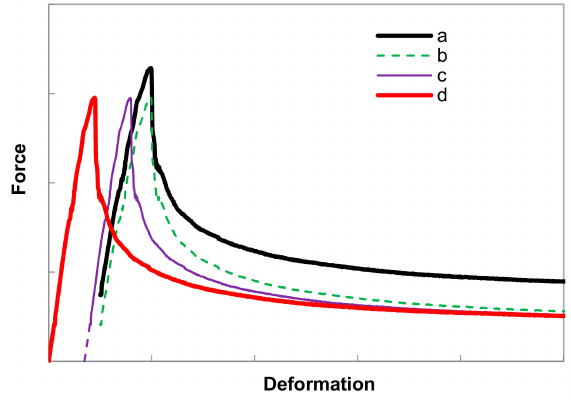
Figure 9. Schematic view of corrections made on the experimental data.